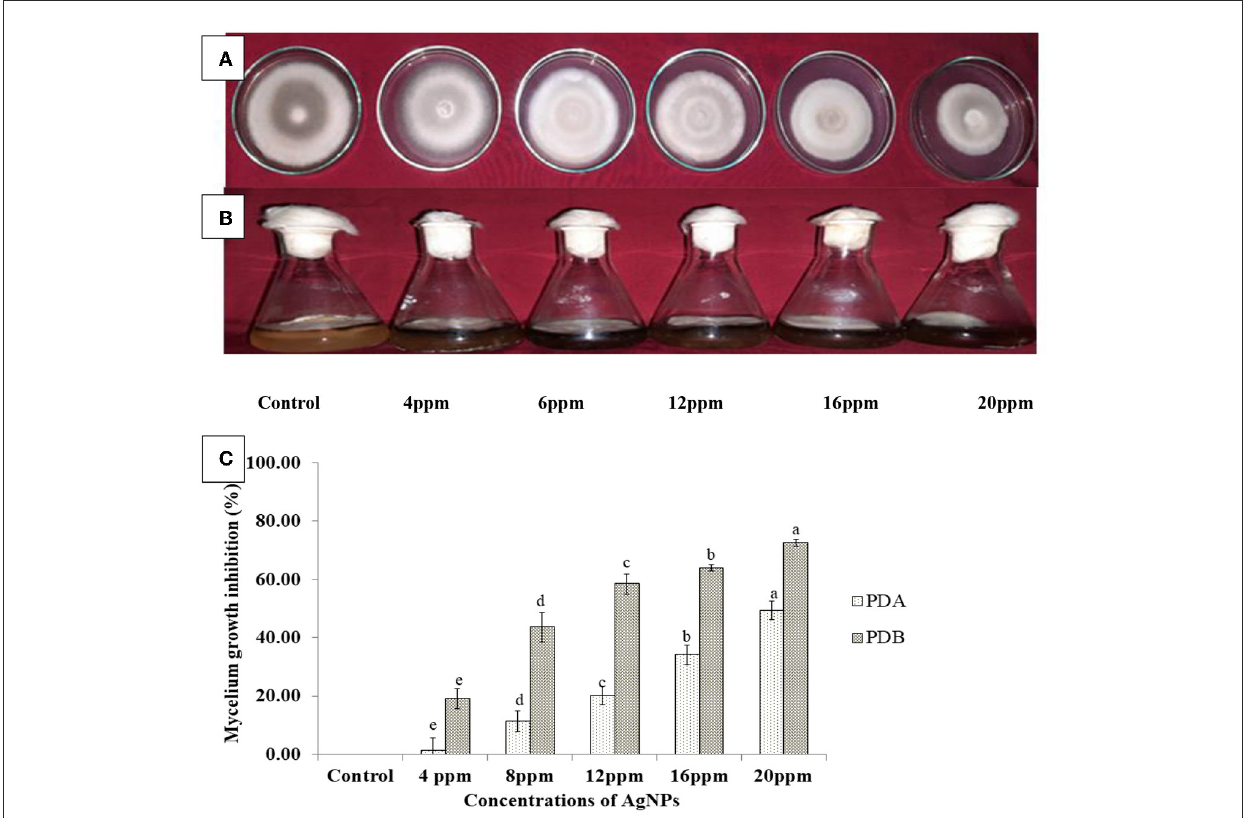
FIGURE8 In vitro efficacy of the synthesized Ag NPs at different concentrations against A. solani on (A) potato dextrose agar (PDA) and (B) potato dextrose broth (PDB). (C) Data were means ± standard errors (SEs) of three replicates, and bars with different letters represent treatments that were significantly different when subjected to Duncan’s multiple range test ( p <